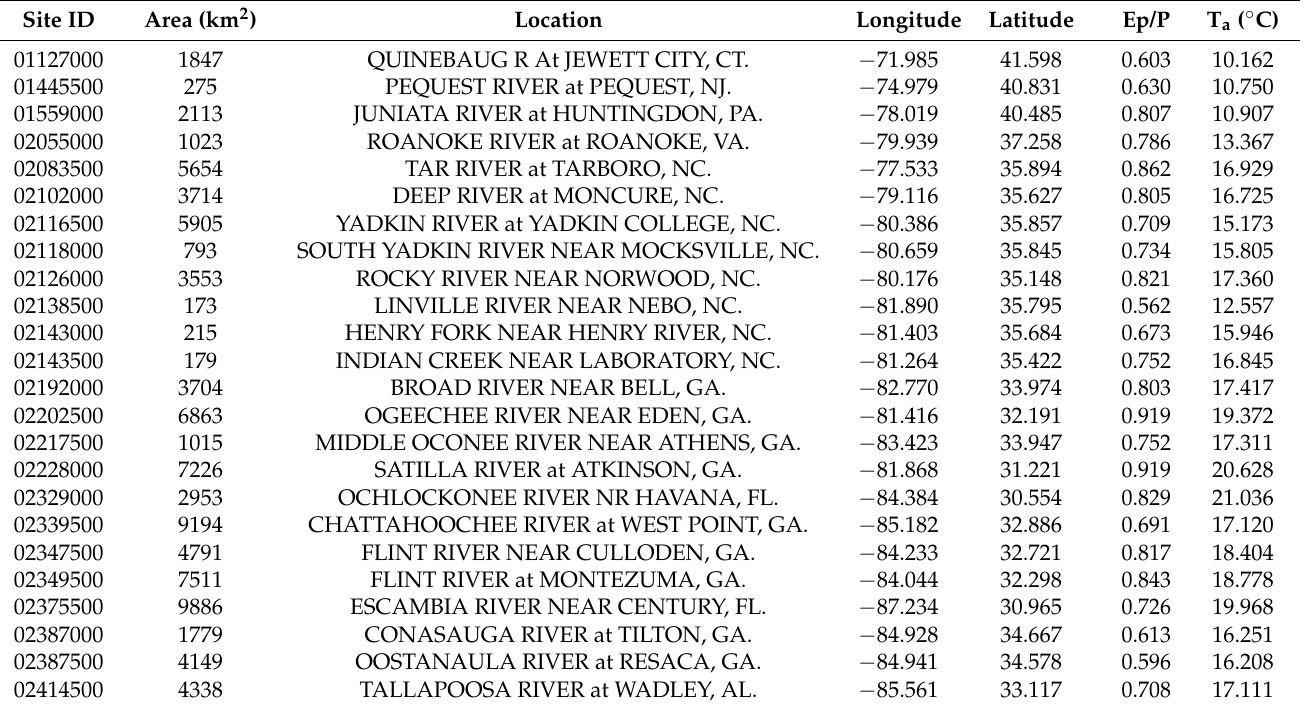
Figure 4. The location and boundary of the study catchments where the proposed daily water balance model is applied. Table 5. Description of the 92 catchment areas located in the U.S.